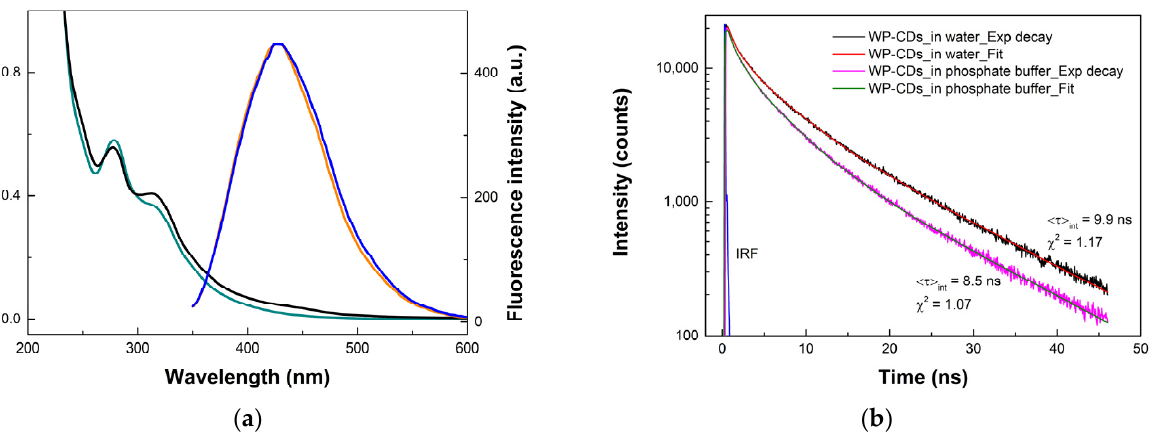
Figure 1. ( a ) Absorption spectra of WP-CDs (0.1 mg/mL) in water (green line) and phosphate buffer (pH = 7.2) (black line) and the corresponding emission spectra (orange line, water; blue line, buffer), when excited at 340 nm. ( b ) time-resolved intensity decays (excitation at 340 nm and observation at 426 nm) obtained by SPT method of WP-CDs in the two media.